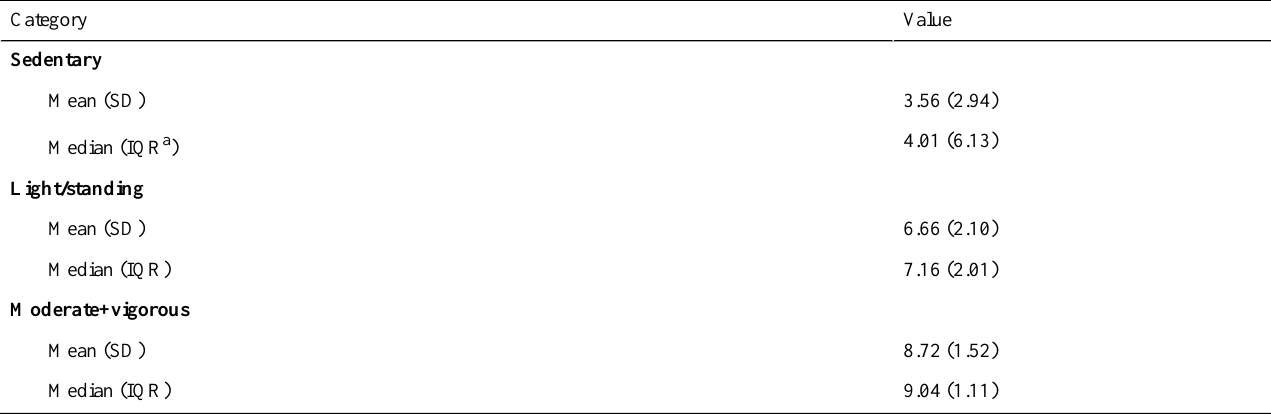
Table 2. ln(Counts + 1) measured on ankle for each μEMA